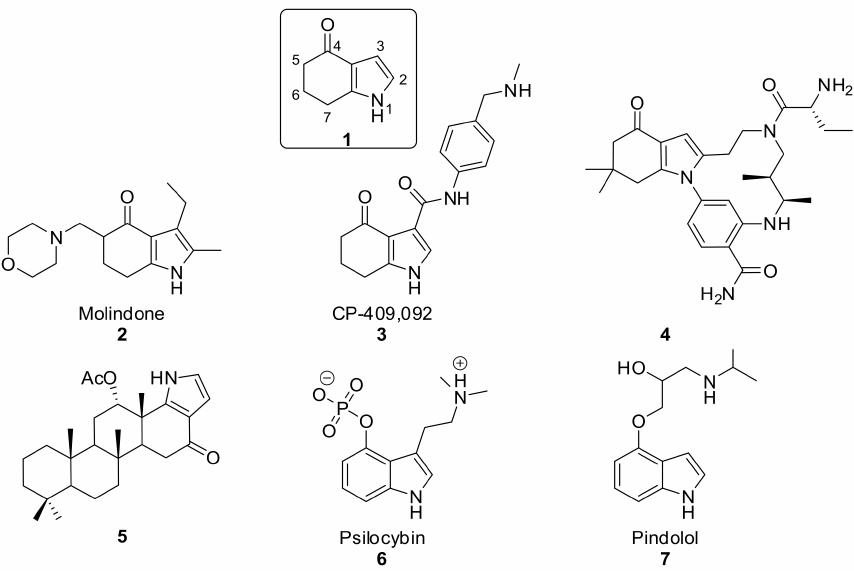
Figure 1. 4,5,6,7-tetrahydroindol-4-one 1 motif in drug design and natural